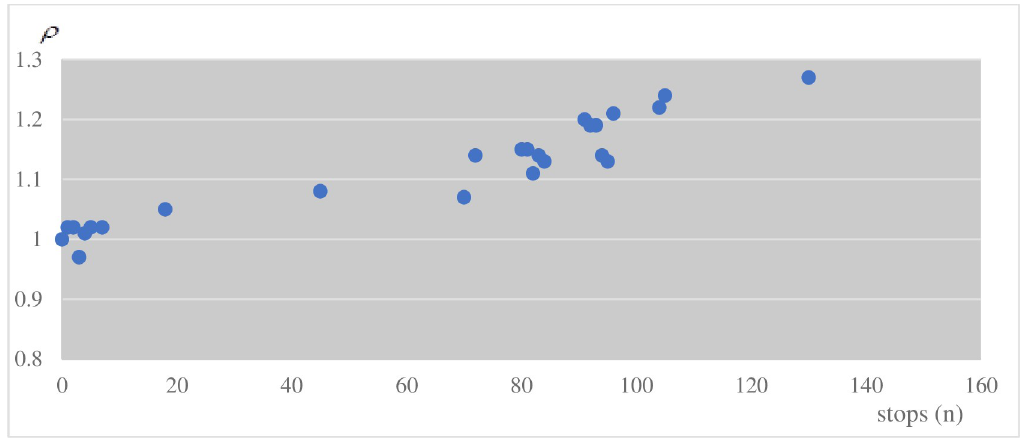
Fig 10. The relation between ρ and the number of the car